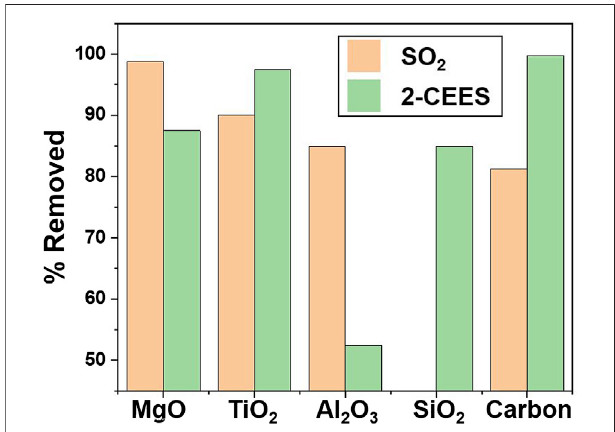
FIGURE 5 | Comparison of various high surface area oxides and carbon for adsorption of SO 2 and 2-CEES, data adapted from Winter et al.